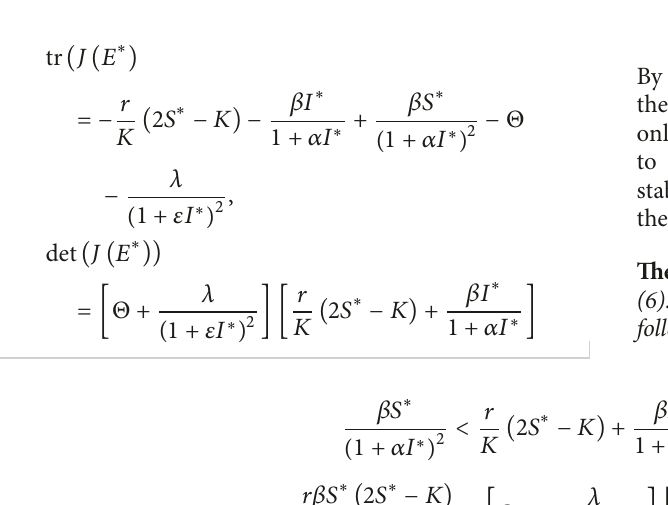
and the characteristic equation is 𝜁 2 − tr (𝐽(𝐸 ∗ ))𝜁 + det (𝐽(𝐸 ∗ )) = 0 ,